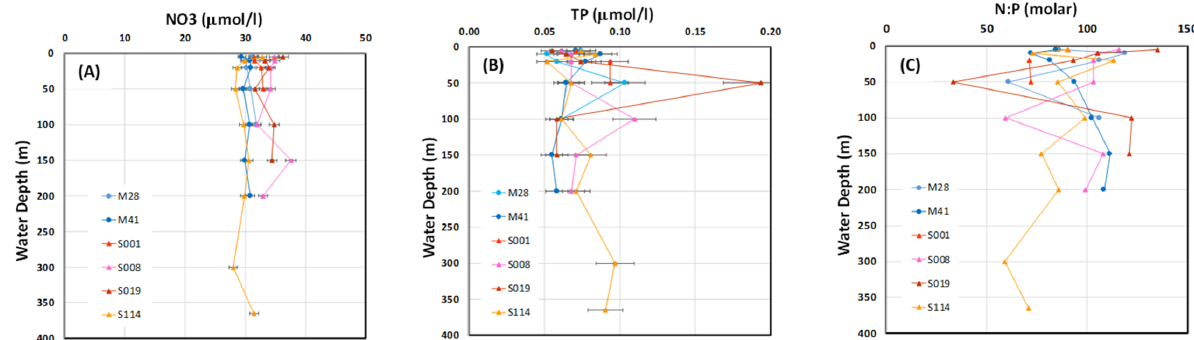
Figure 3. Nutrients in LM and LS sample locations. Shown are ( A ) nitrate (NO3), ( B ) total phosphorus (TP), and ( C ) molar NO3- N:TP ratio in filtered LM and LS samples. Note that not all samples were available for analysis. Error bars on x axis data represent the 95% uncertainty (U95), which was 2.3% and 12.9% for nitrate and TP, respectively.